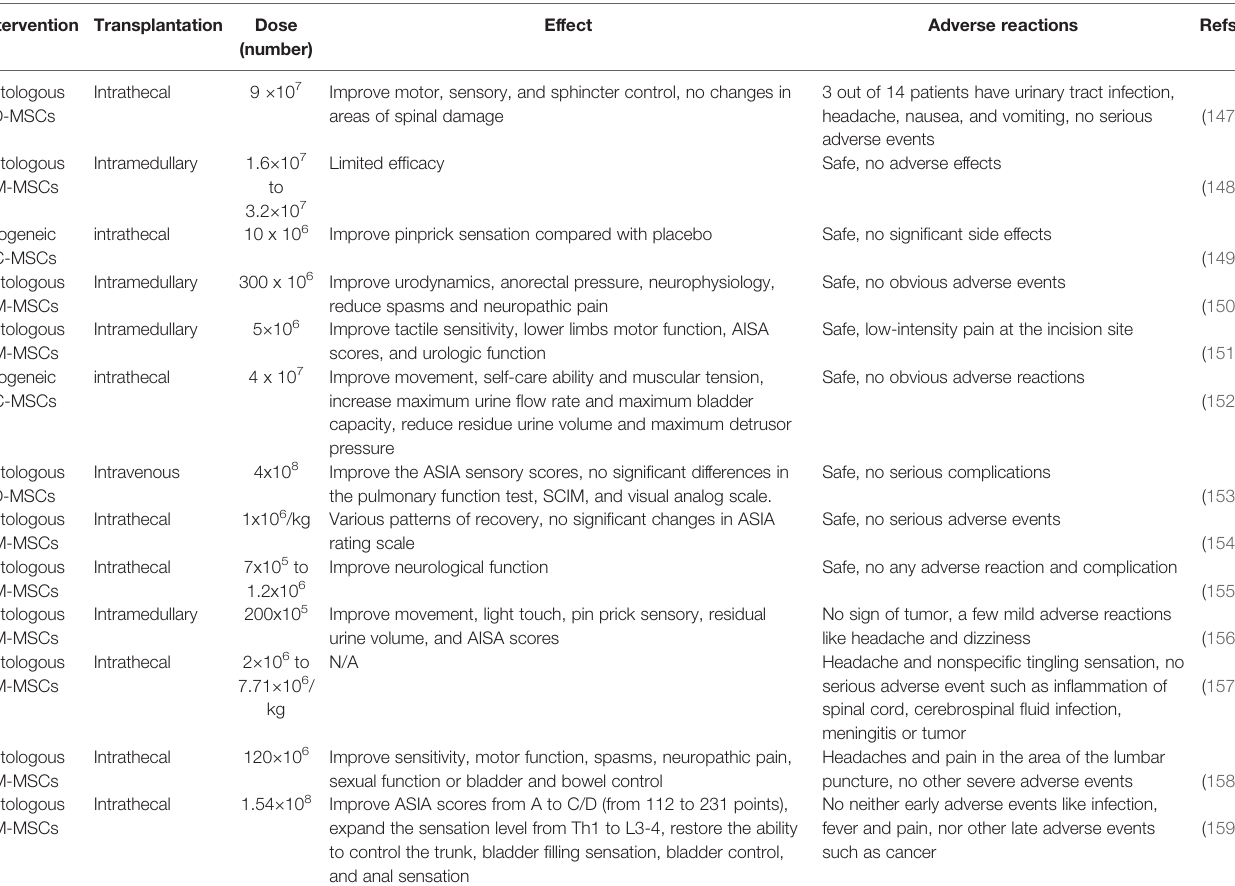
TABLE 2 | MSCs with therapeutic potential for SCI